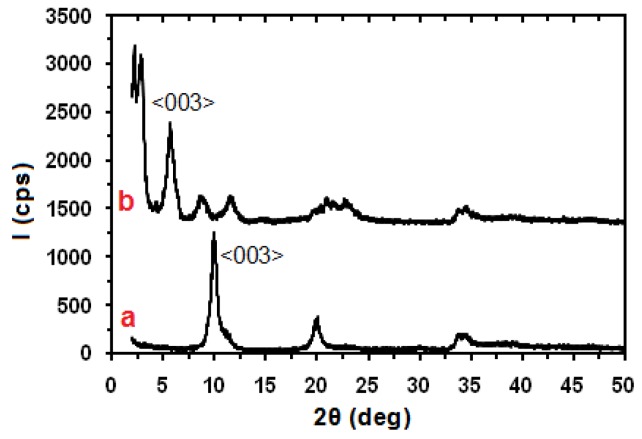
X-ray diffraction (XRD) pattern of (a) pristine Zn3Al layered double hydroxide (LDH) and (b) stearate-Zn3Al LDH.